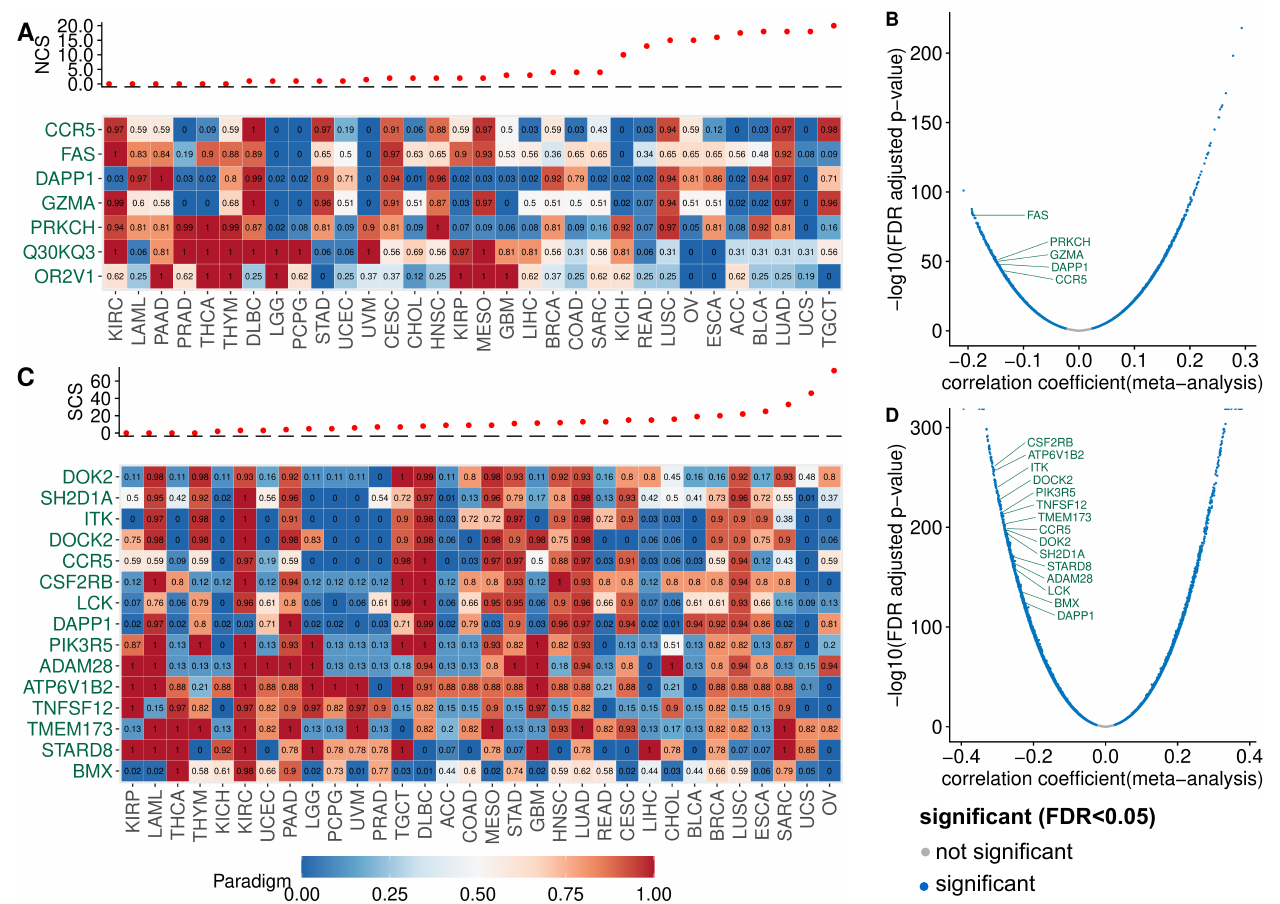
Figure A6. Paradigm pathway activity and gene expression negatively associated with CIN. ( A ) The PARADIGM pathway-level activities corresponding to protein-coding genes (rows) were cor- related with the NCS. Only pathways with a significant negative correlation (FAD-adjusted p < 5%) less than − 0.3 in at least seven cancer types were included. The heatmap shows the normalised PARADIGM pathway activity (0–1 from low to high). Cancer types are ordered according to their median NCS, see top panel. ( B ) Volcano plot for the correlation between gene expression and NCS, highlighting gene names corresponding to PARADIGM features that are significantly negatively associated with NCS. ( C ) Analogous to ( A ), but for the SCS instead of the NCS. ( D ) Correlation of SCS and gene expression, analogous to ( B